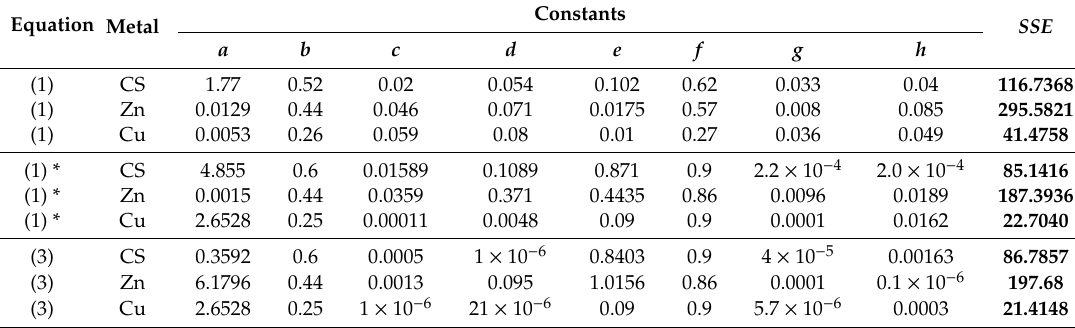
Table 6. Normative corrosivity estimation based on calculated first-year corrosion losses. Set of constants and sum of the quadratic error for carbon steel, zinc, and copper using the dose–response functions given by Equations (1) and